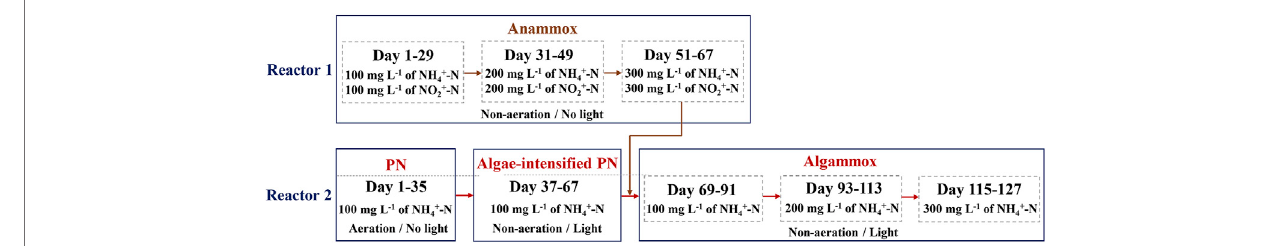
FIGURE 1 | Operation strategy for nitrogen removal. PN denotes partial nitri fi cation.